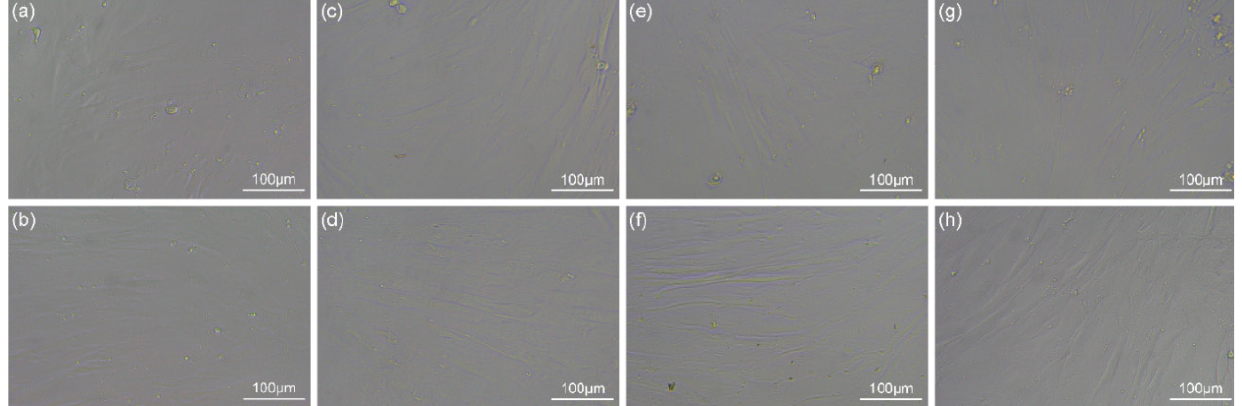
Figure 14. Morphologies of HGFs after 48 h and 72 h culture under 200× light microscope. ( a , c , e , g ) Morphologies of HGFs after 48 h culture; ( b , d , f , h ) Morphologies of HGFs after 72 h culture; ( a , b ) control; ( c , d ) cured pure resins; ( e , f ) HA/BAG ceramics; ( g , h ) hybrid polymer–ceramic materials.